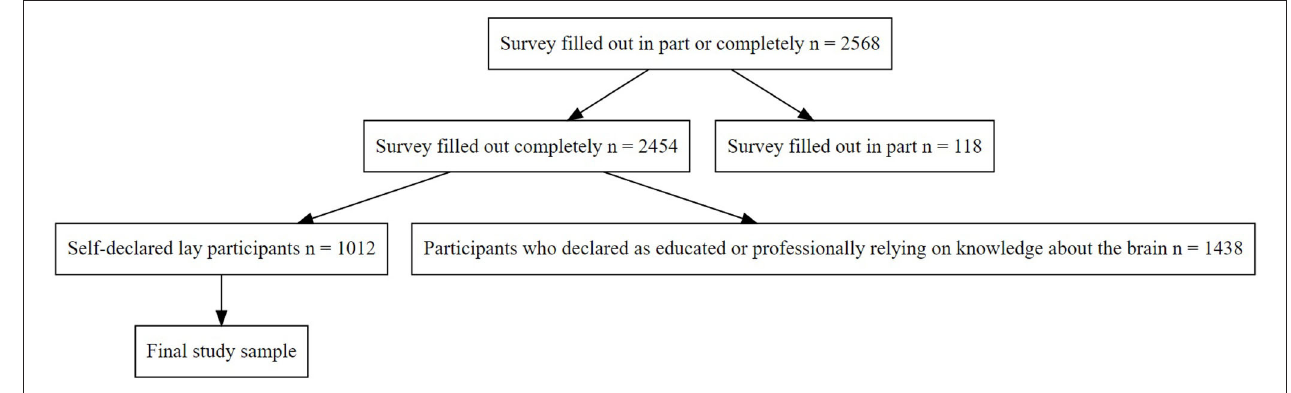
FIGURE 1 | Flowchart of the selection